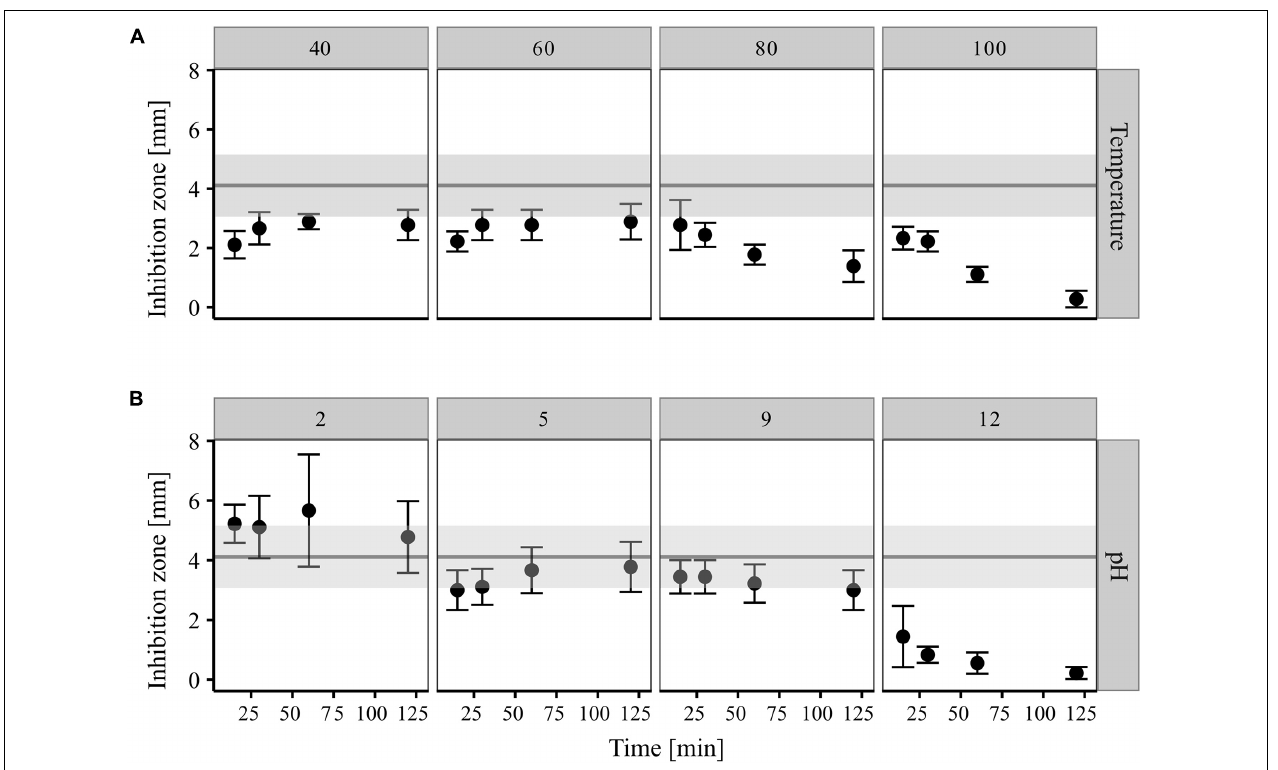
FIGURE 5 | Impact of temperature (A) and pH (B) treatments on antagonistic activity of CP157 cultures extracts (XAD-7, 50 mg/ml, aq ). Different exposure times are given on the X-axis. Range of inhibition zones caused by untreated culture extract (control) are represented by the gray horizontal bar. Values are means (95% confidence interval, n = 9). The figure was created using the tidyverse package in R (Wickham et al.,